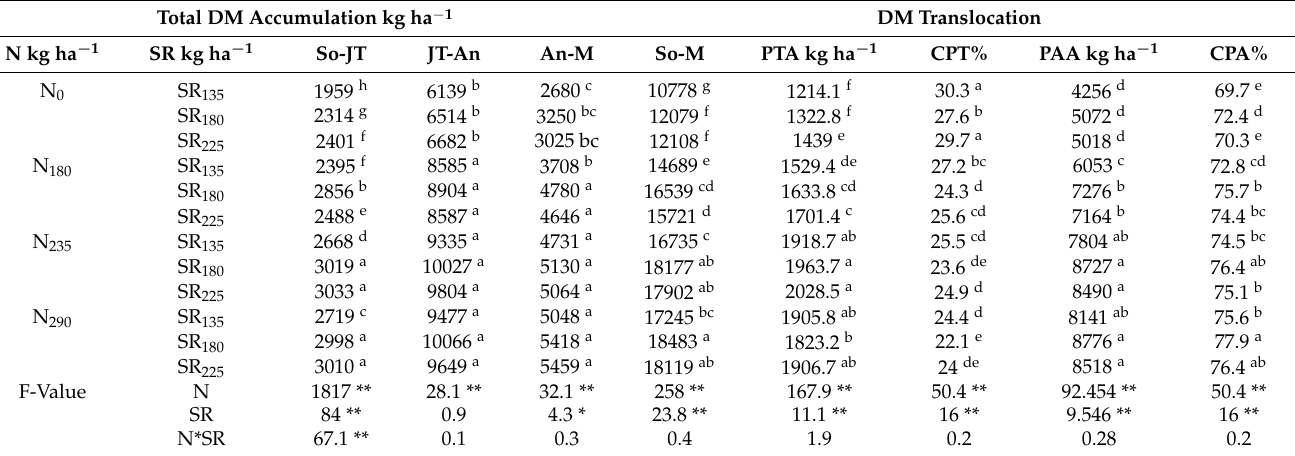
Table 2. Combination effects of N and SR on DM accumulation, translocation in